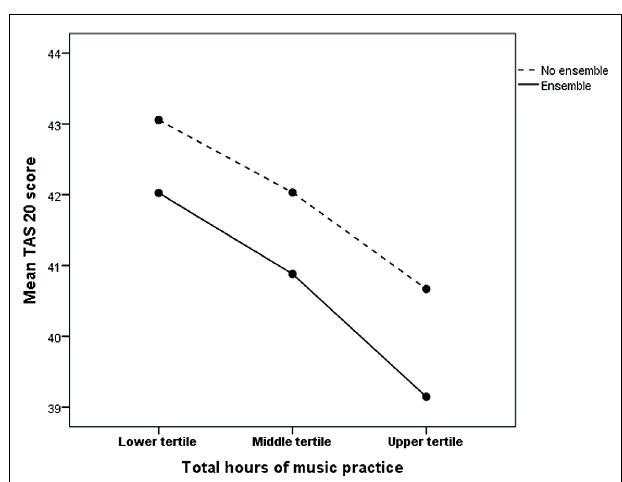
Table 3 |Twin correlations for monozygotic (MZ) and dizygotic (DZ) pairs (female, male, and opposite sex pairs separately) zygosity (bottom) forTorontoAlexithymia Scale and hours of practice corrected for